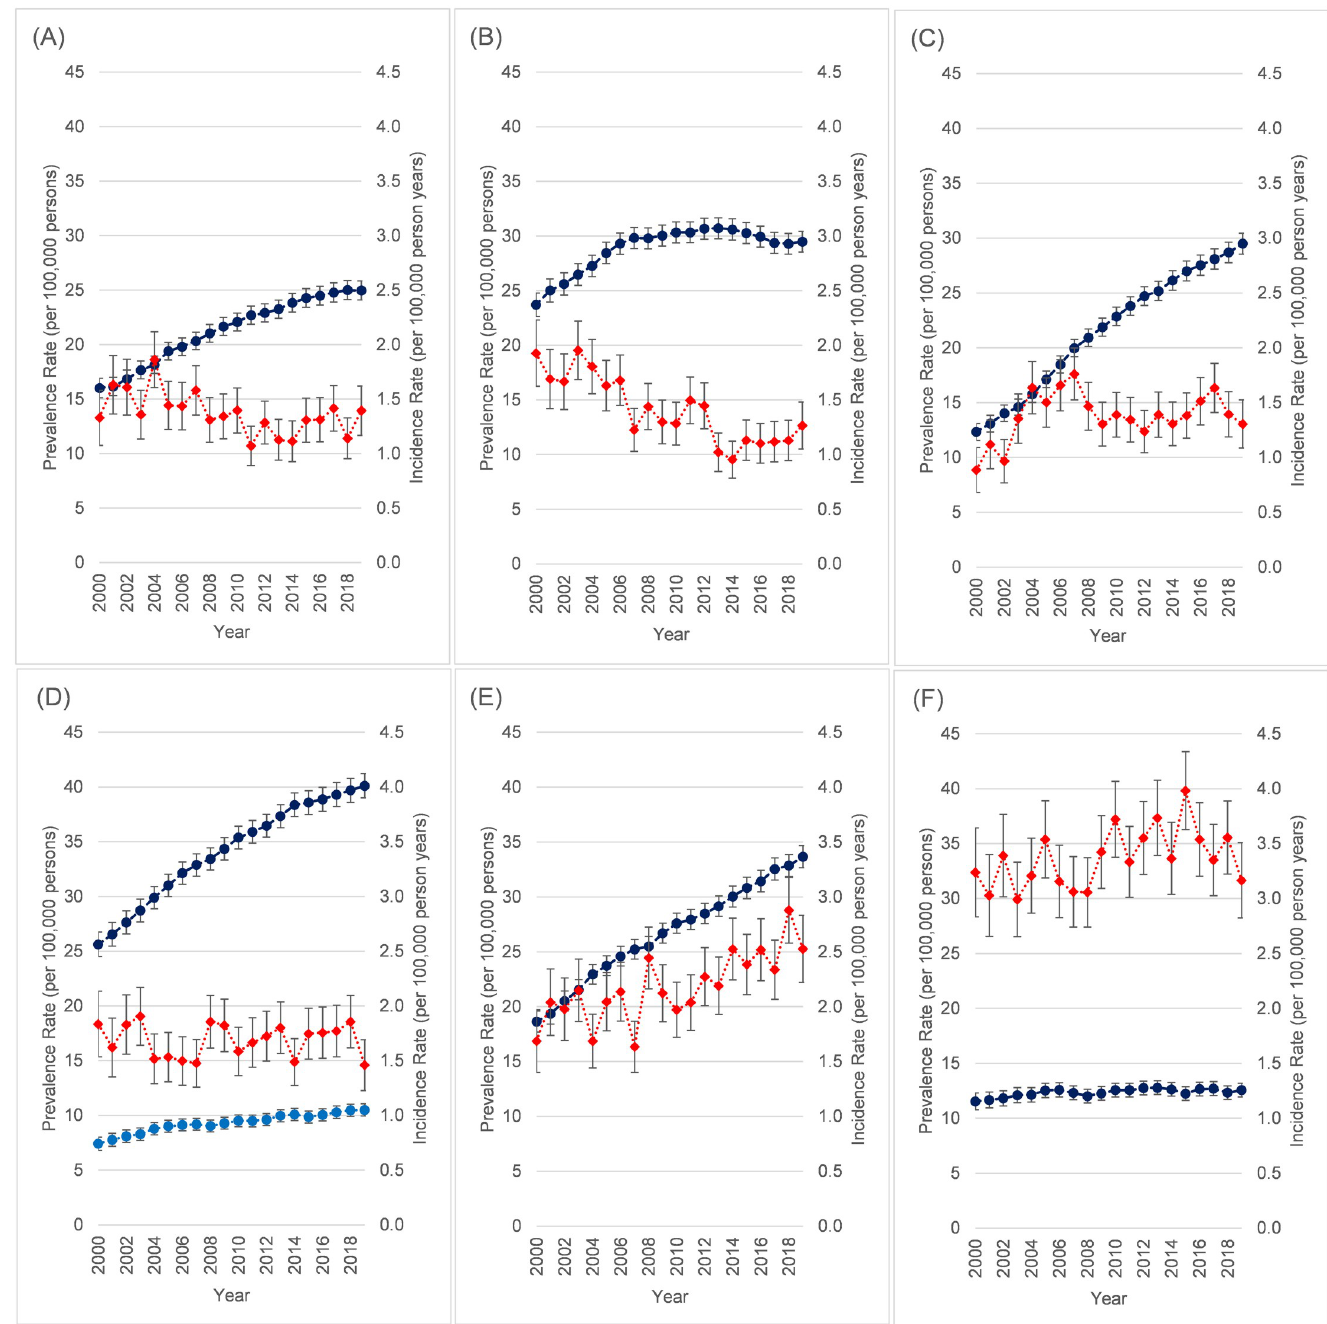
Fig 4. Time trends in neuromuscular disease 2000–2019 by selected condition. (A) Inflammatory myopathy. (B) Muscular dystrophy. (C) Charcot-Marie Tooth. (D) Guillain-Barre syndrome. (E) Myasthenia gravis. (F) Motor neurone disease. Dark Blue = Lifetime prevalence rate per 100,000 persons. Light Blue = Lifetime prevalence rate per 100,000 persons excluding Guillain-Barre´ syndrome codes not recorded in previous 5 years (D only). Red = Incidence rate per 100,000 person- years. Both rates age standardised to CPRD population as of 1/1/2019. 95% confidence intervals shown for each.